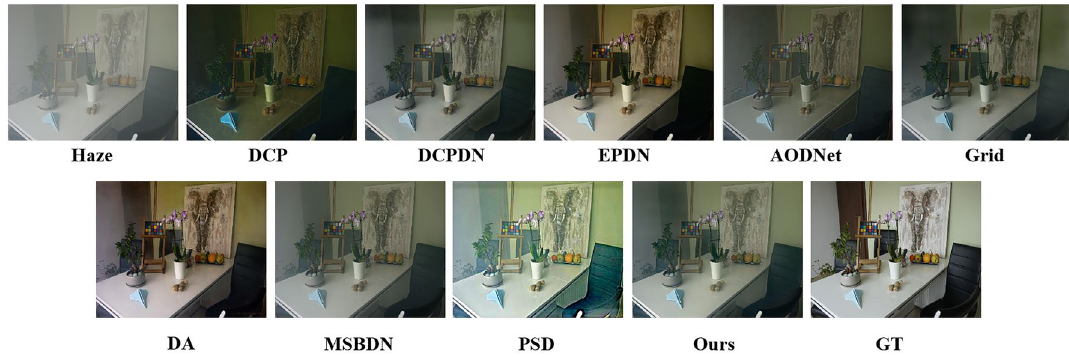
Figure 6. Results of comparison experiments on the I-HAZE.